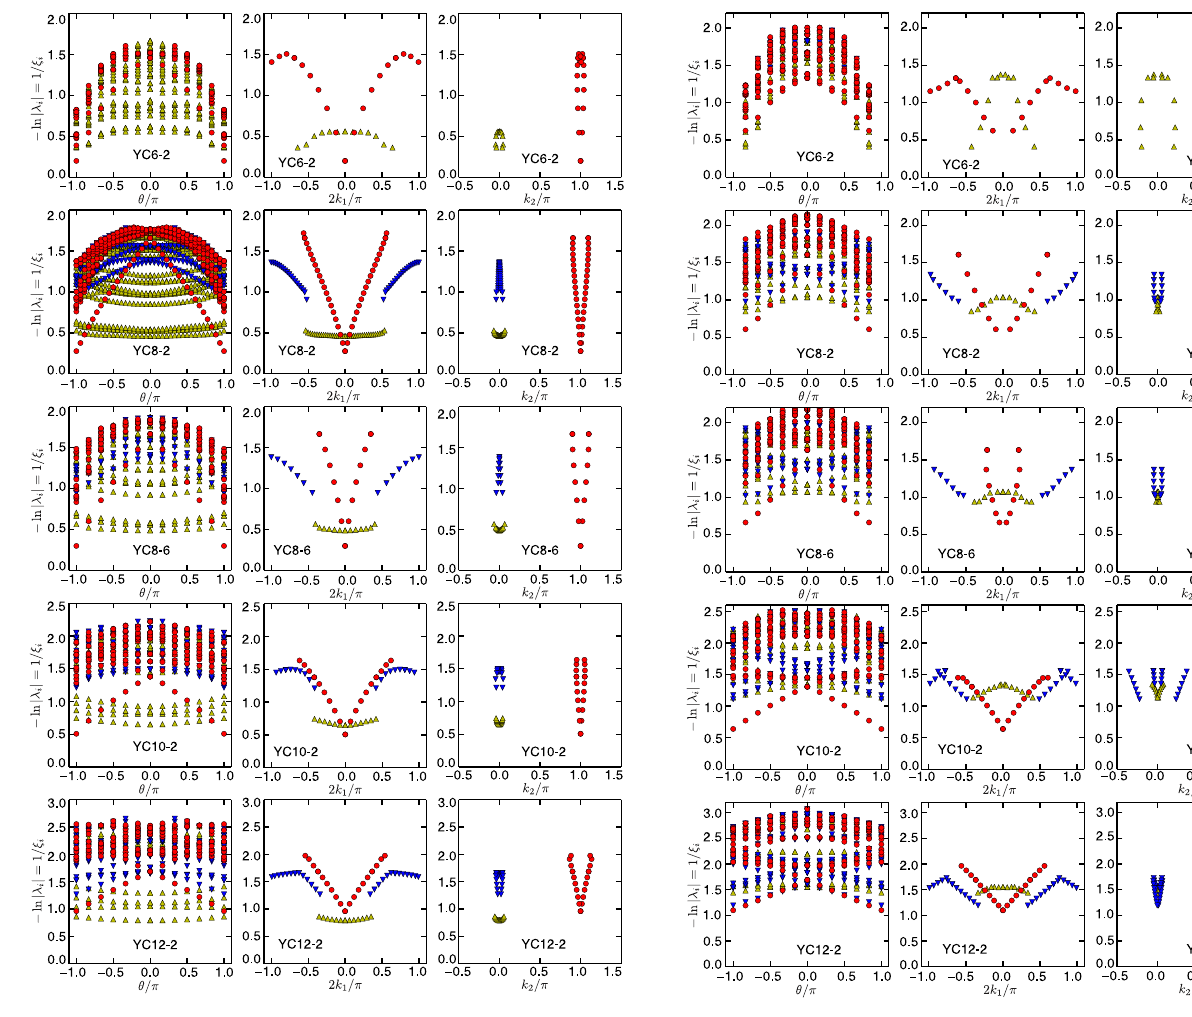
FIG. 12. The S z ¼ 1 transfer matrix spectrum of J 2 ¼ 0 for the YC6-2, YC8-2, YC8-6, YC10-2, and YC12-2 cylinders. Here, the bond dimension is m ¼ 6000